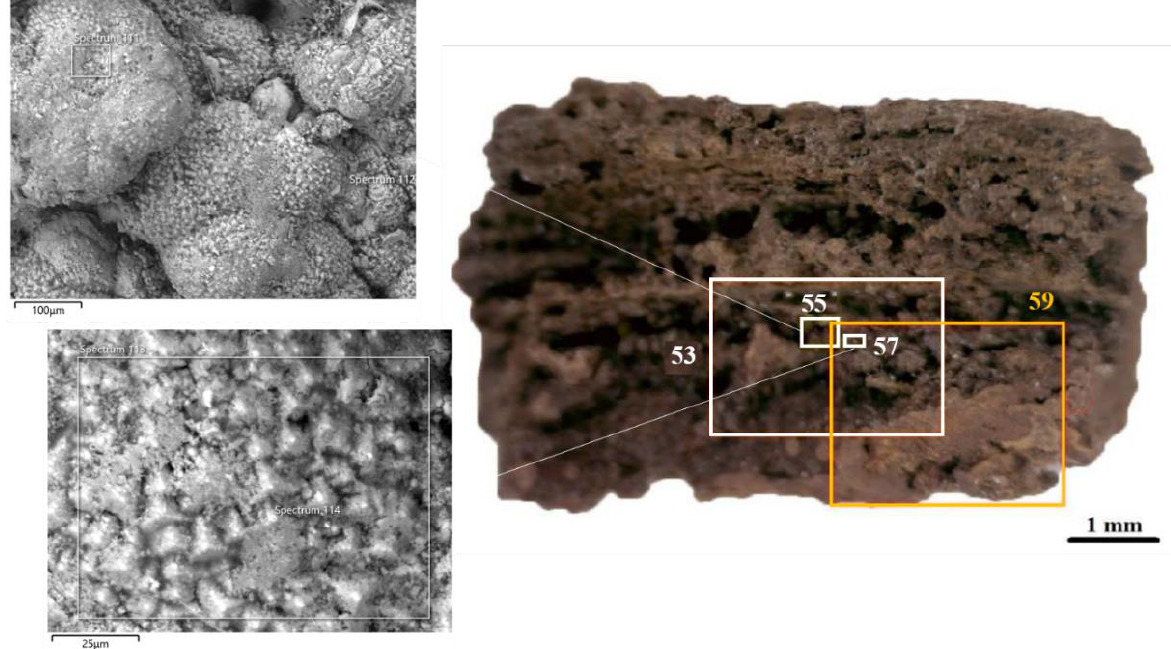
Figure 6. Schematic of the areas investigated by SEM-EDS for sample 5. The spherules are shown in area 53 and two details 55 and 57, colored white. Area 59, colored in yellow, had a homogeneous appearance. SEM images are related to detail 55 and 57.